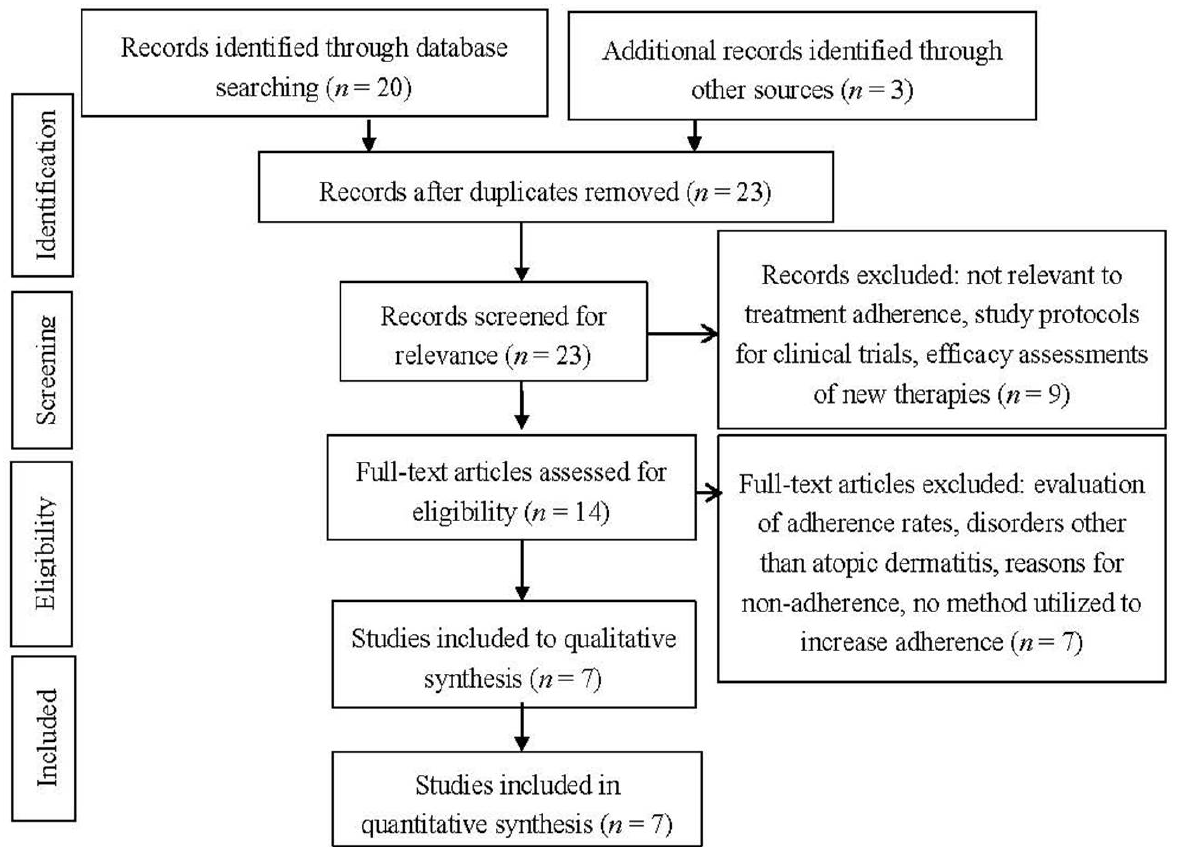
Figure 1. Preferred Reporting Items for Systematic Reviews and Meta-Analyses (PRISMA) 2009 flow